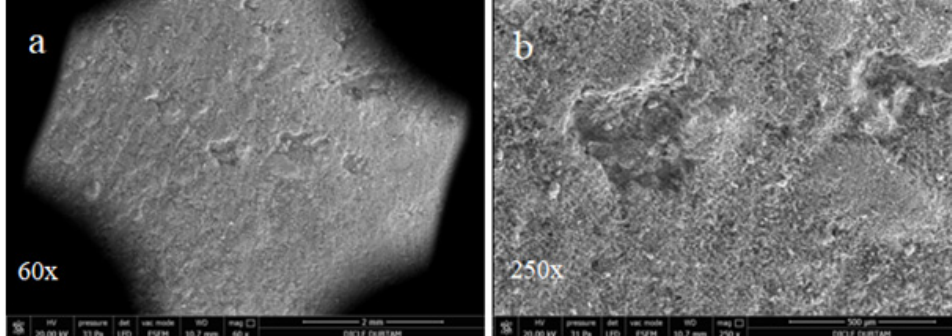
Figure 11. SEM images of control bar samples without replacement cured for 90 days in hydropath: ( a ) 60×; ( b ) 250×.